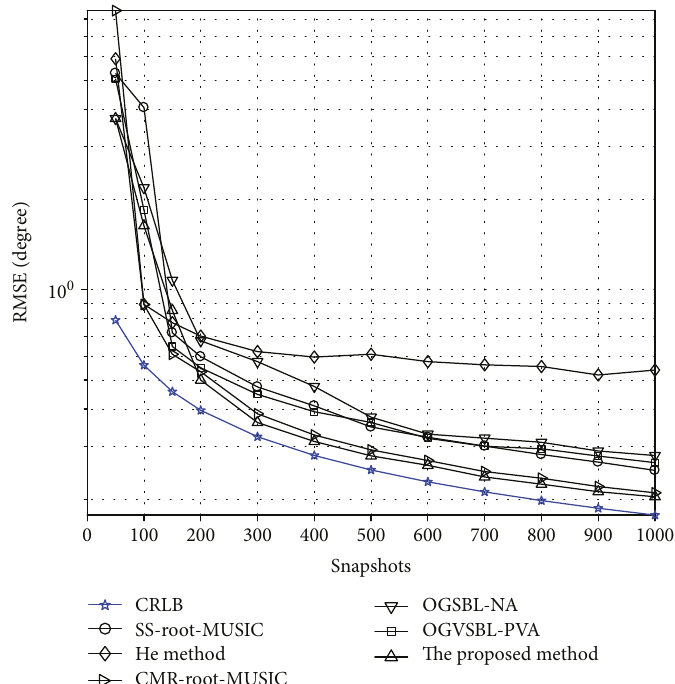
Figure 7: RMSEs of DoA estimation versus snapshot number for M = 6 , K = 7 , and SNR =0dB.